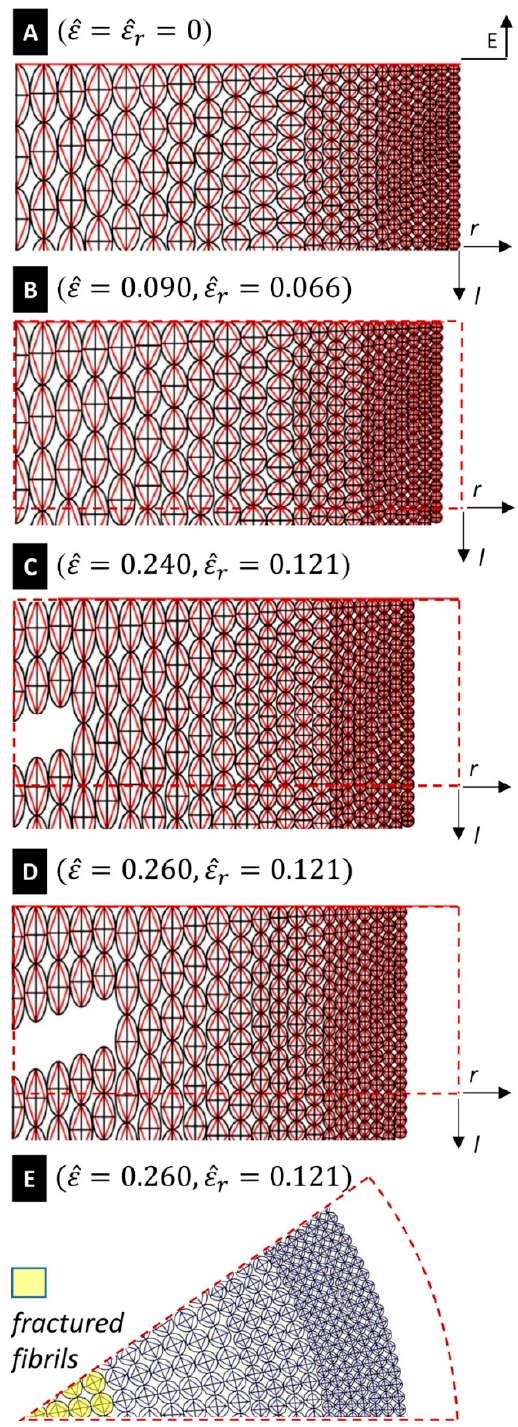
Figure 5. Snapshots of fibre deformation under di ff erent values of the applied longitudinal strain ˆ ε . The quantity ˆ ε r denotes the radial strain that accompanies ˆ ε due to Poisson’s e ff ect. ( A – D ): Longitudinal sections of the stretched fibre in correspondence with di ff erent levels of strain. ( E ) transverse cross-section E-E of the fibre under ˆ ε = 0.260 and ˆ ε r = 0.121 (r and l, respectively, denote radial and longitudinal axes; dashed lines mark the undeformed configuration of the fibre).